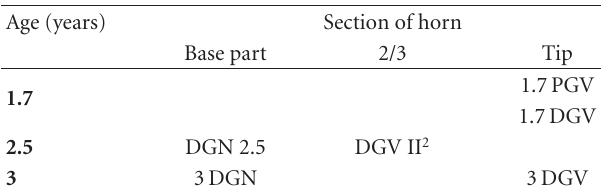
Table 1: Samples of saiga